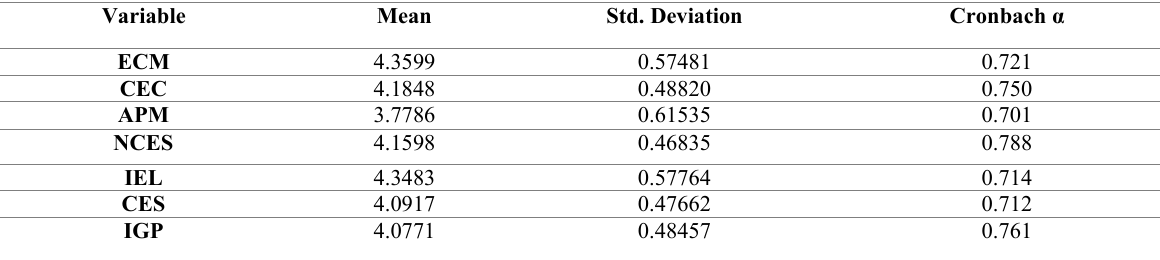
Table 1: Descriptive Statistics for Variables